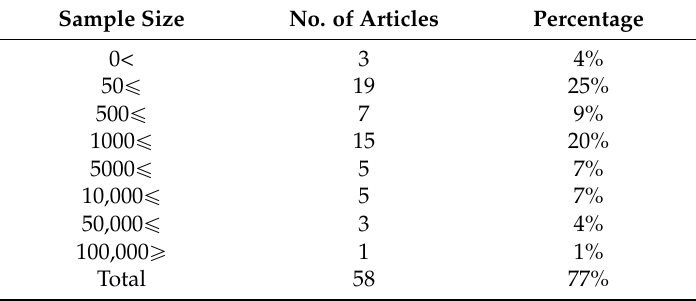
Figure 3. Numbers of studies by geographical location. Table 2. Summary of sample sizes used in selected papers.